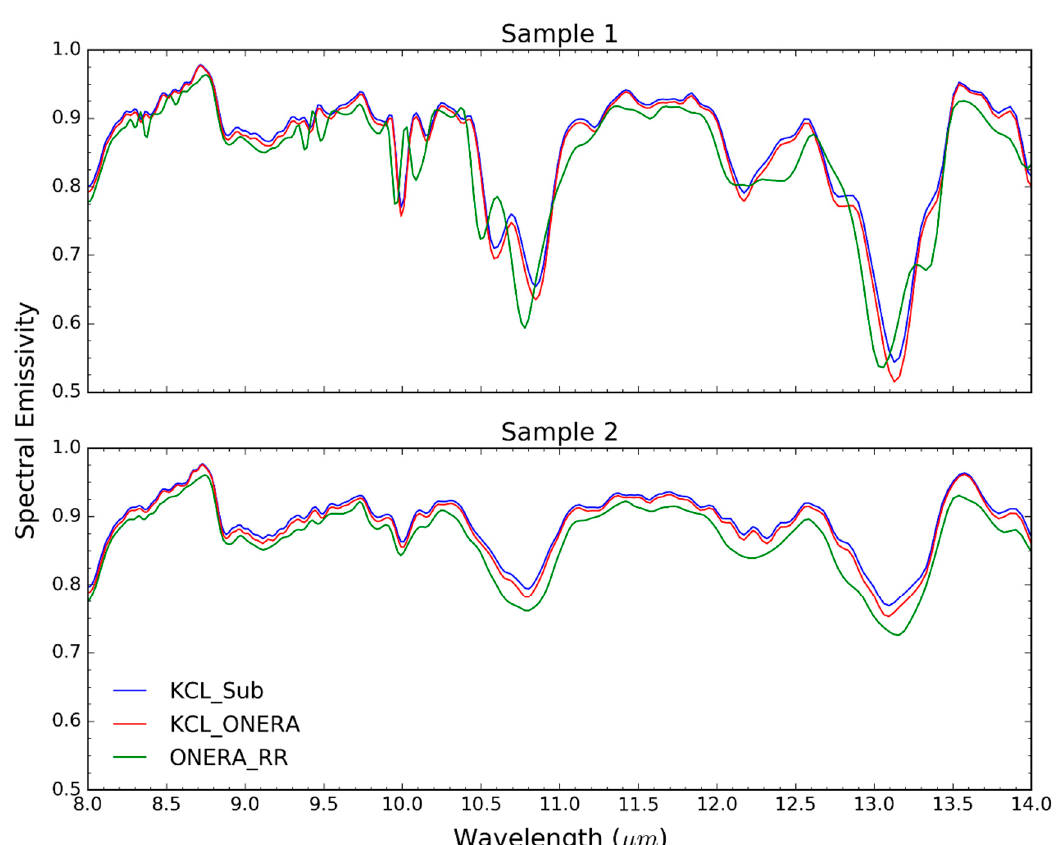
Figure 11. Surface spectral emissivities of the artificial samples Sample 1 and Sample 2, shown over the 8–14 µ m spectral region and measured at KCL using the substitution method with the KCL reference standard (KCL_Sub) and the ONERA reference standard (KCL_ONERA), and at ONERA using the substitution method with the ONERA reference standard (ONERA_RR).